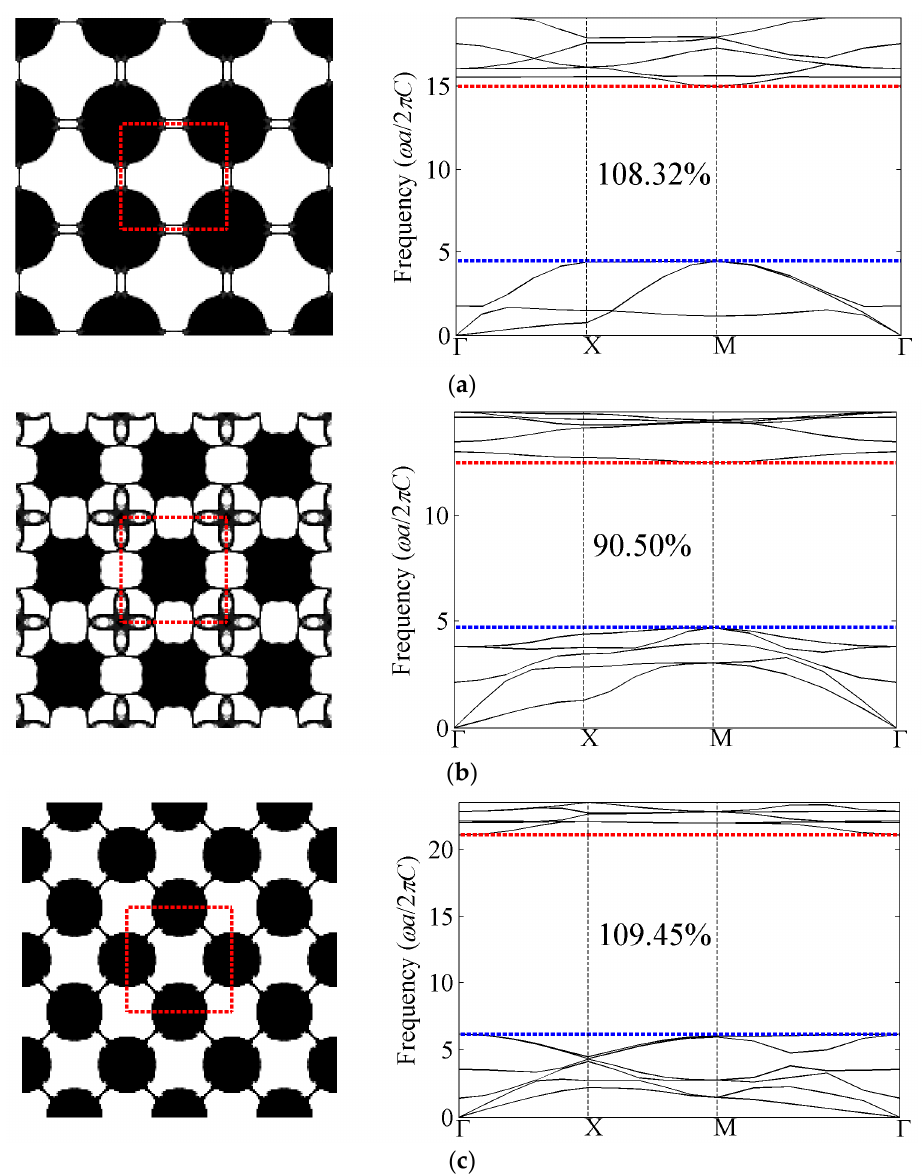
Figure 9. Optimized topologies and corresponding band structures for in-plane mode with bulk modulus constraint. ( a ) The third band gap; ( b ) the fifth band gap; and ( c ) the sixth band gap.